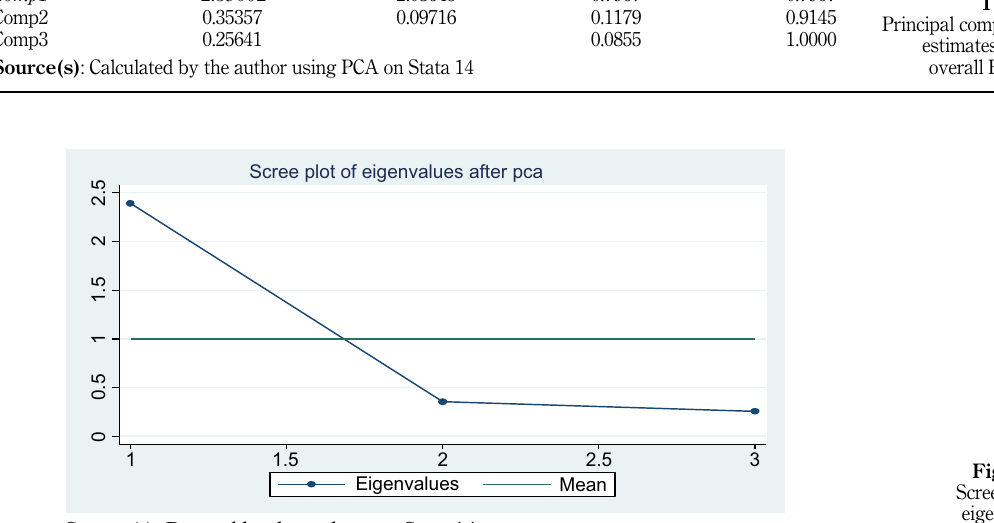
Table 4. Principal